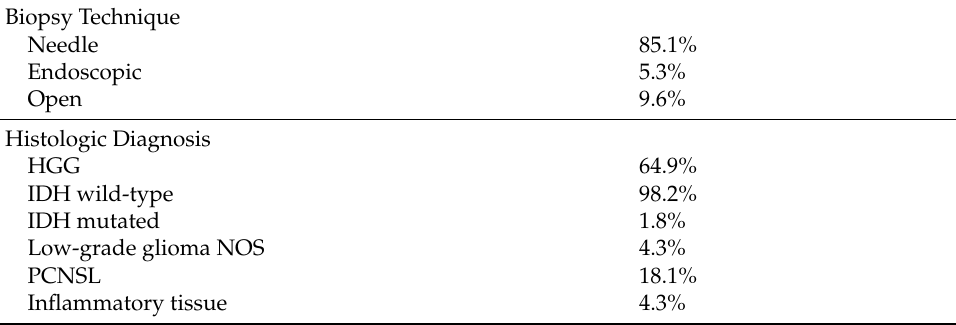
Table 1. Surgical data of 94 brain biopsy procedures. Biopsy